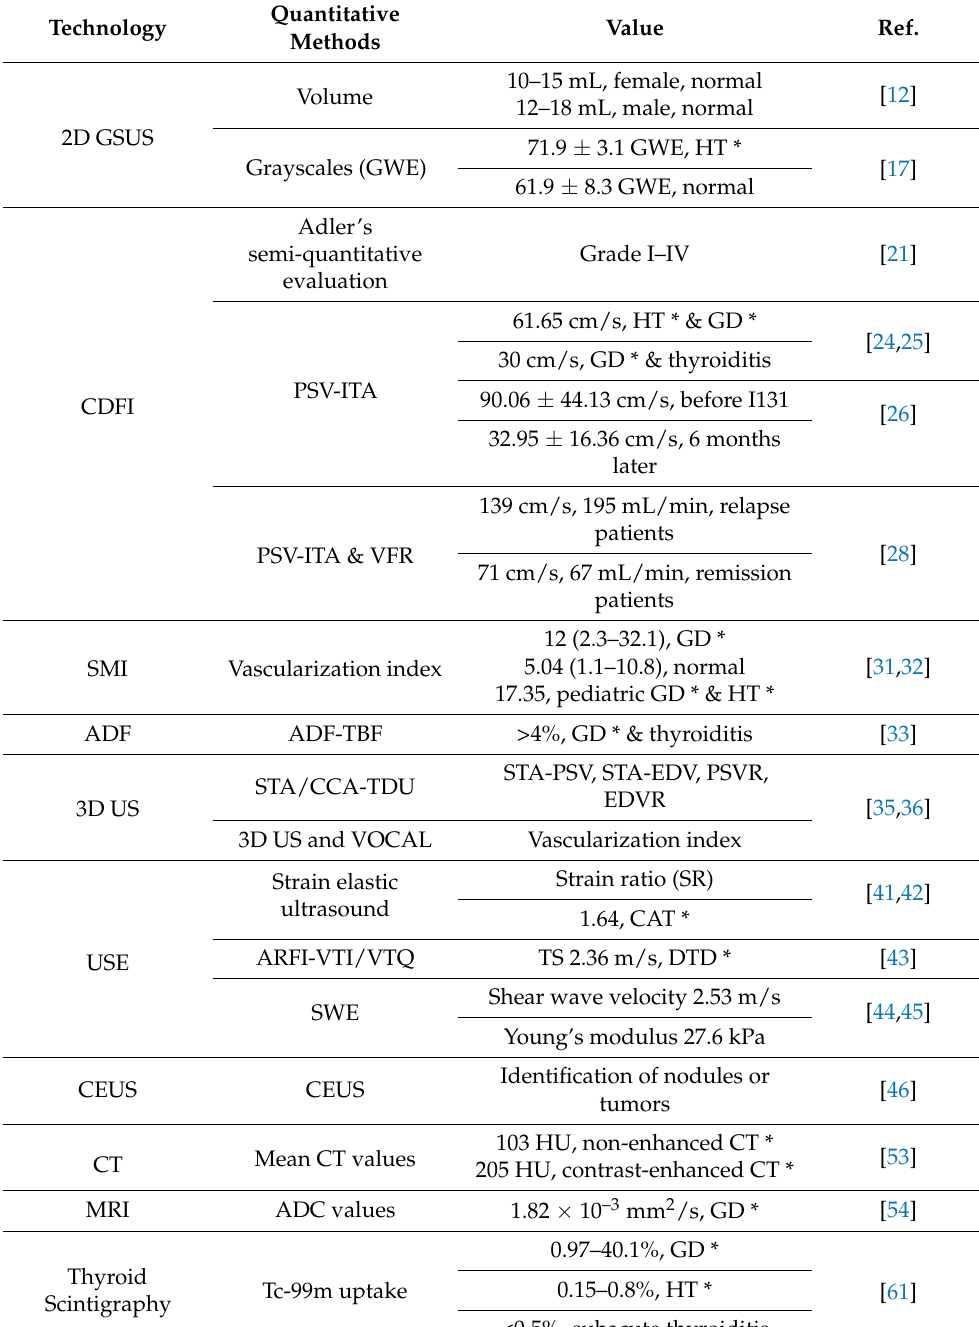
Table 1. A brief summary of the application of high-frequency ultrasound (HFUS) and other quanti- tative imaging diagnosis technologies in diffuse thyroid